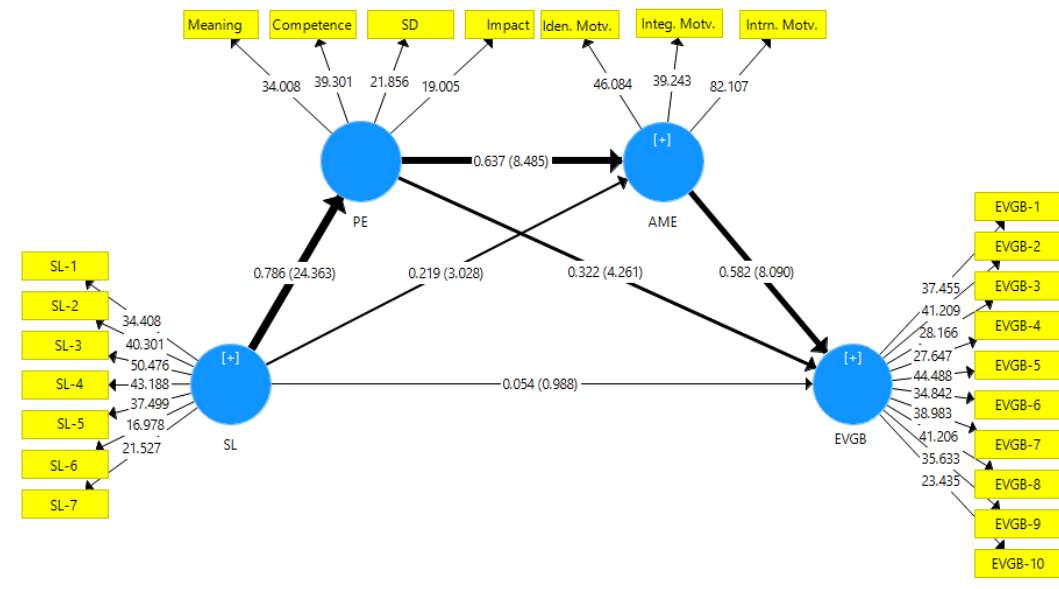
Figure 2. Structural model.